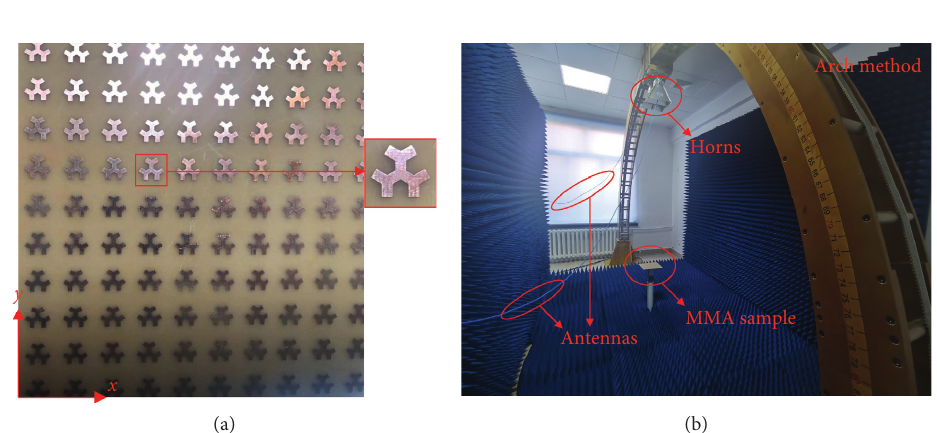
Figure 10: Living photos: (a) MMA sample; (b) test equipment.